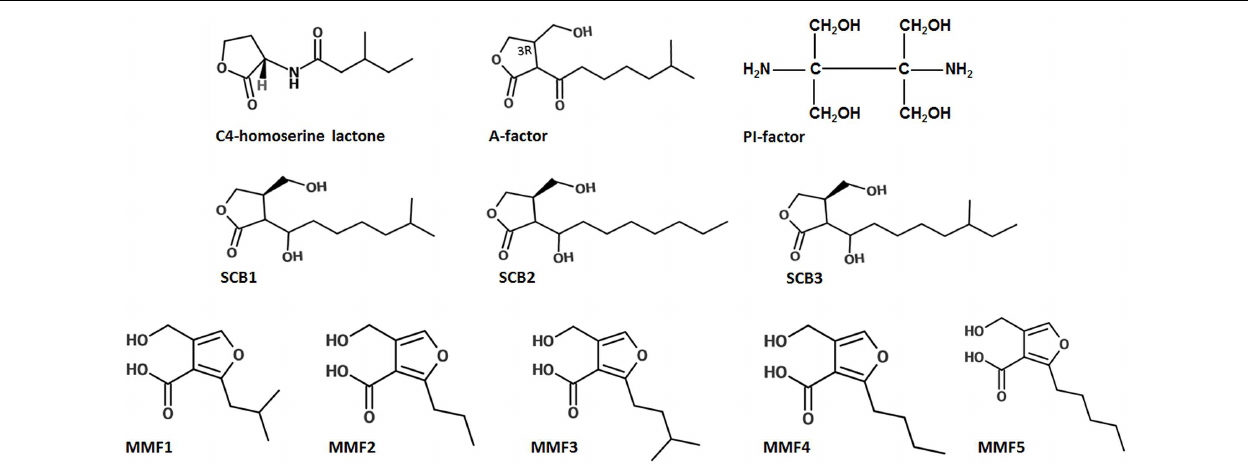
FIGURE 3 | Structures of representative signaling molecules in Actinobacteria . The A-factor of Streptomyces griseus , the GBLs of S. coelicolor (SCB1, SCB2, and SCB3), MMFs of S. coelicolor which are structurally distinct sharing a common 2-alkyl-4-hydroxymethylfuran-3-carboxylic acid core structure but differ in the identity of the C2 alkyl group. The C4-homoserine lactone of Pseudomonas aeruginosa is shown for comparison. Adapted from Willey and Gaskell (2011).